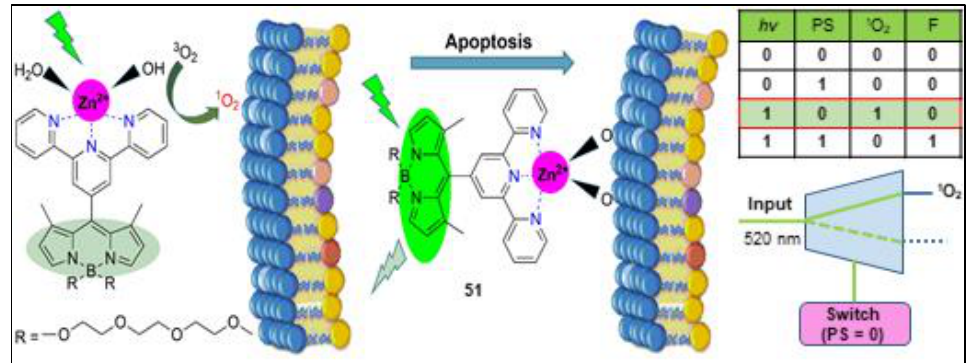
Figure 49. Compound 51 induces apoptosis and then switches to diagnostic mode and fluorescently tags apoptotic cells. Adapted with permission from [153]. Copyright (2018) Springer Nature.